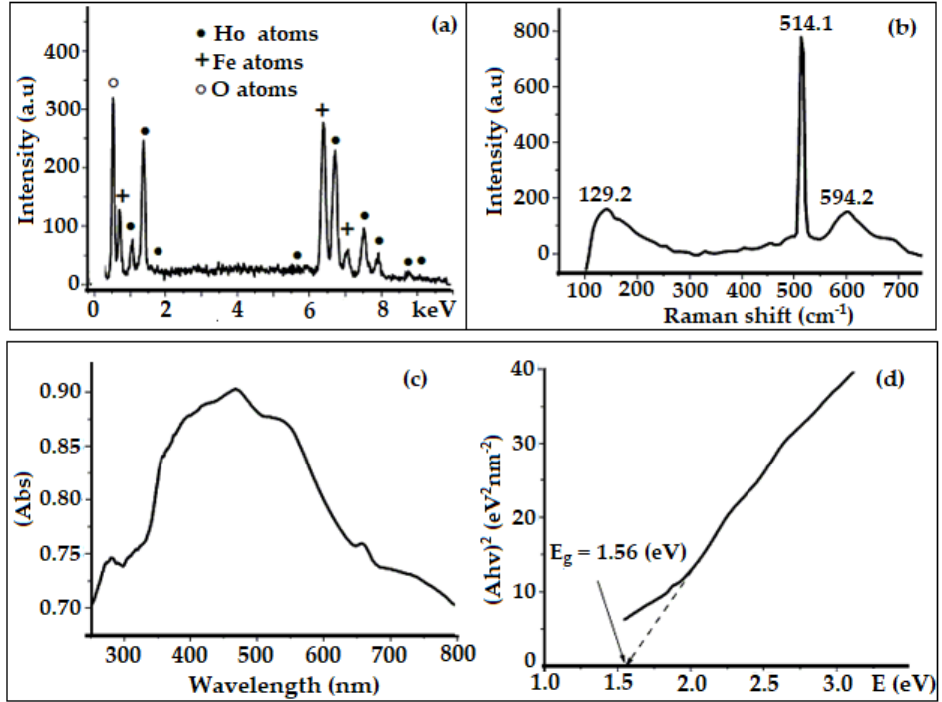
Figure 3. EDXA ( a ), Raman( b ), UV-Vis ( c ) spectra, and Plots of (Ahv) 2 as a function of photon energy ( d ) of HoFeO 3 nanoparticles annealed at 750 °С for 1 h. Table 1. Characteristics of HoFeO 3 nanoparticles in this work and that from the published literatures as a comparison. HoFeO 3